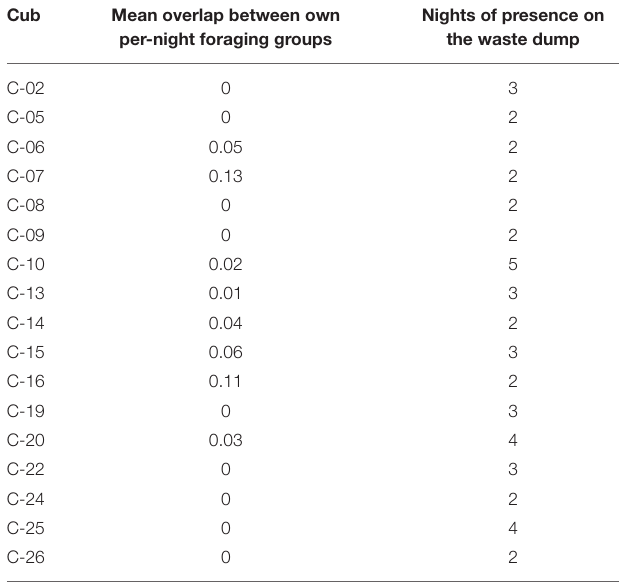
TABLE 1 | Degree of overlap (Jaccard similarity) between per-night foraging groups for each cub that was present more than one night. Cub Mean overlap between own Nights of presence on per-night foraging groups the waste